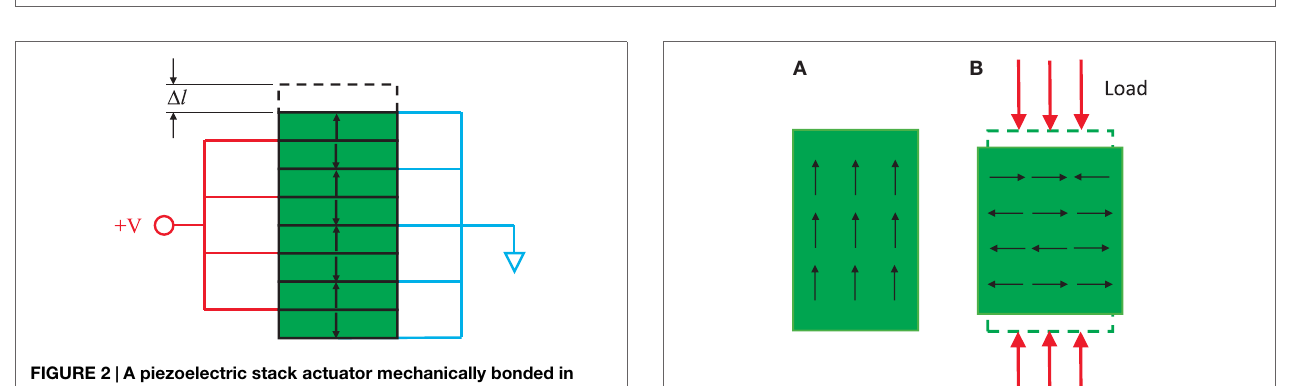
FIGURE 1 | (A) Example of a flexure-guided XY nanopositioner (Yong et al., 2009). (B) Finite-element simulated motion of the nanopositioner, showing the deformation of flexures.